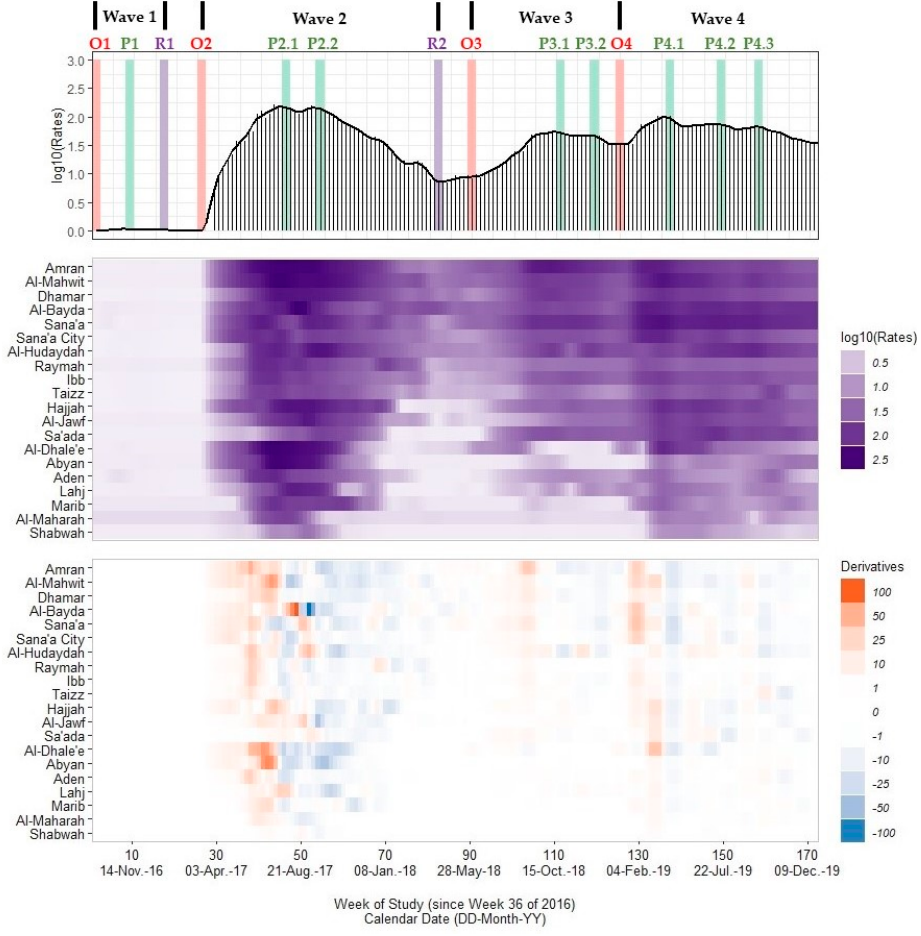
Figure 2. A multi-panel plot of the national Yemeni cholera outbreak signature (top panel), a heatmap of rate values across 20 governorates (middle panel; excludes the Hadramaut and Socotra island governorate), and a heatmap of differences in rates or trivial derivative values (bottom panel). Cholera rates (cases per 100,000 persons, or cph) are presented as a spike plot using a log10-transformed scale for 172 study weeks (all missing data imputed with linear approximations). A smoothed time series line plot is superimposed on this spike plot, which was calculated using Kolmogorov–Zurbenko adaptive filters from Week 36 (4–11 September) of 2016 through Week 52 (23–29 December) of 2019. Smoothed rates (laboratory-confirmed cholera cases per 100,000 persons) were estimated using the best performing smoother. Vertical bars represent the onset timing (red) for each wave (O1, O2, O3, O4), the peak timing (green) including one peak for Wave 1 (P1), two peaks for Wave 2 (P2.1, P2.2) and Wave 3 (P3.1, P3.2), and three peaks for Wave 4 (P4.1, P4.2, P4.3), and the resolution timing (purple) for Waves 1 and 2 (R1, R2). The heatmap of rates uses a purple gradient scale (lighter hues ~0.0 cph and darker hues ~400 cph) while the heatmap of derivative values uses a diverging scale ranging from − 100 (dark blue) to +100 (dark orange) with values near zero in grey. All plots share a common horizontal axis of time reported in weeks since Week 36 of 2016 (defined as study Week 0). Governorates are grouped by assigned outbreak clusters: the core outbreak (Sana’a, Sana’a City, and Al-Hudaydah), immediate neighboring I (Amran, Al-Mahwit, Dhamar, and Al-Bayda), immediate neighboring II (Raymah, Ibb, and Taizz), northern (Hajjah, Al-Jawf, and Sa’ada), southern (Al-Dhale’e, Abyan, Aden, and Lahj), and eastern (Marib, Al-Maharah, and Shabwah) clusters. Data used to develop this visualization are reported in Tables 1 and 2 and Supplementary Excel Tables S3 and